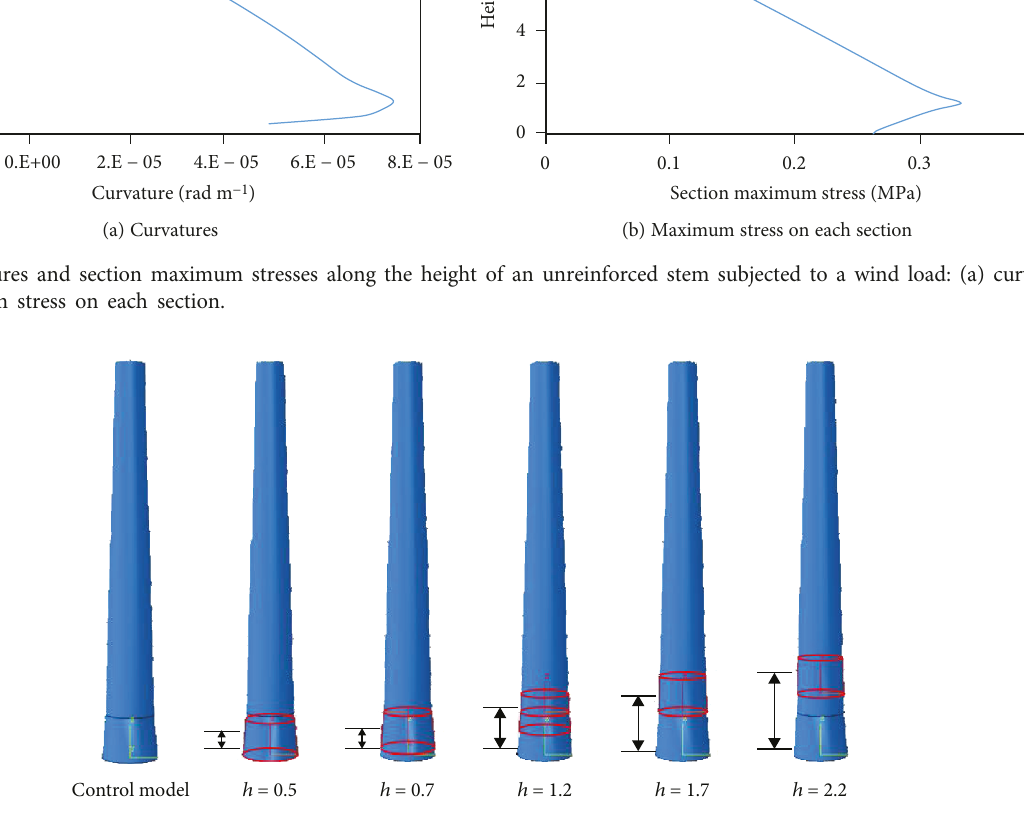
Figure 8: Locations of FRP wraps used for the analysis (h=mid-height of FRP wrap, unit: